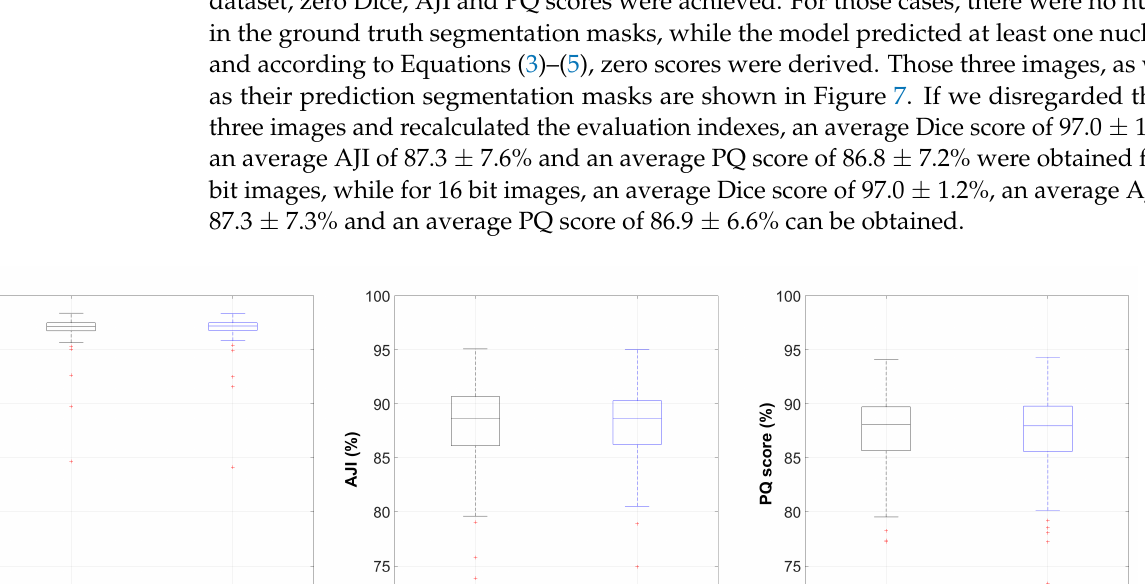
Figure 5. Nuclei instance segmentation performance boxplots for Dice, AJI and PQ scores derived from the BitDepth dataset (Y-axes are limited for a better visualisation, and hence, some outliers are not shown).